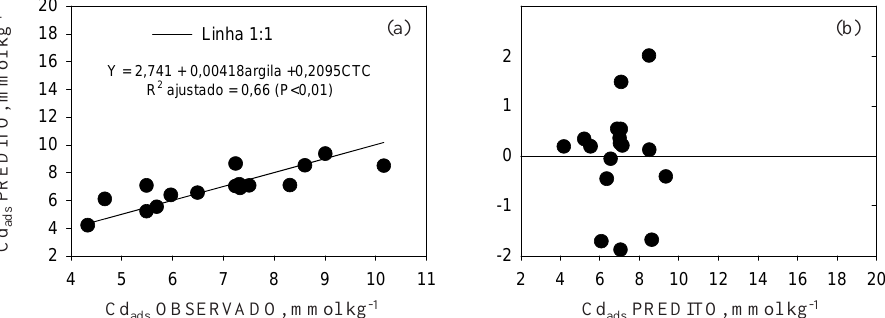
Figura 3. Relação entre a quantidade de Cd adsorvido observada em pH 5,5 e a quantidade estimada pelo modelo que descreve a adsorção neste valor de pH, de acordo com a CTC e teor de argila (a) e resíduos padronizados